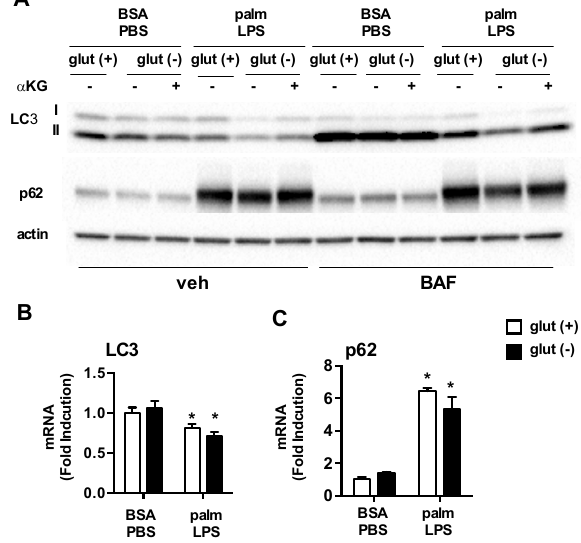
Figure 7. Autophagy is modulated by glutamine deficiency. ( A ) pMACs were treated with BSA ‐ PBS or palm ‐ LPS in glutamine sufficient or glutamine deficient media ± α‐ KG (440 nM). The cells were incubated for 16 h followed by 2 h of veh or bafilomycin (BAF; 50 nM). Protein lysates were analyzed for expression of LC3 or p62. Actin is shown as a loading control; ( B ) Cells were stimulated as indicated for 16 h in media with or without glutamine followed by qRT ‐ PCR assessment of LC3 and p62 mRNA expression. Bar graphs report the mean ± SE for a minimum of 3 experiments, each performed in triplicate. * , p < 0.05 for PBS vs . LPS; #, p < 0.05 glutamine vs . no glutamine.